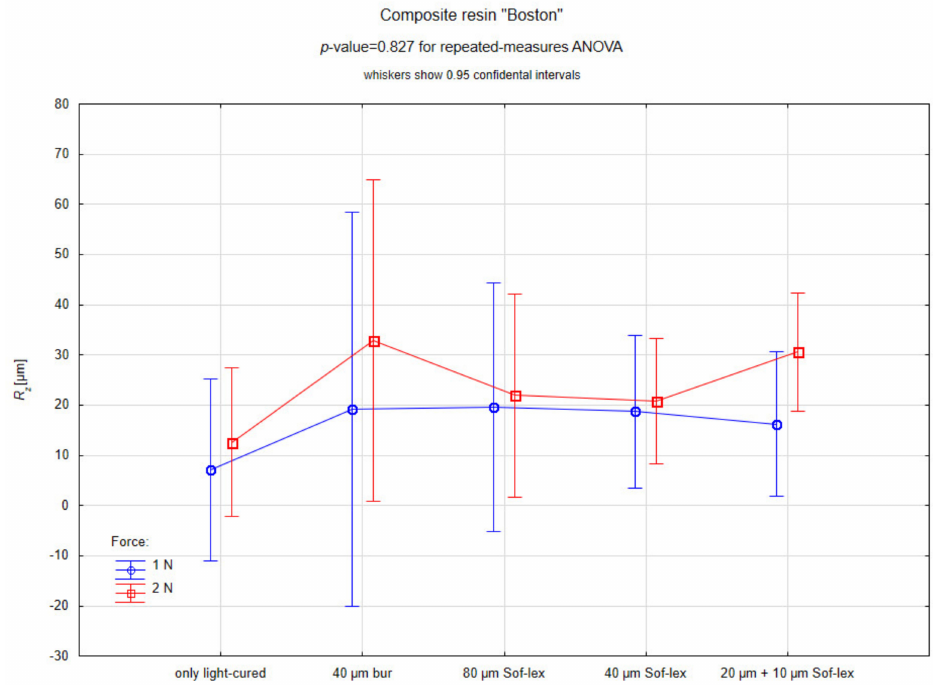
Figure 5. Repeated-measures analysis of variance for R z values in the individual polishing steps depending on the press-on force for Boston